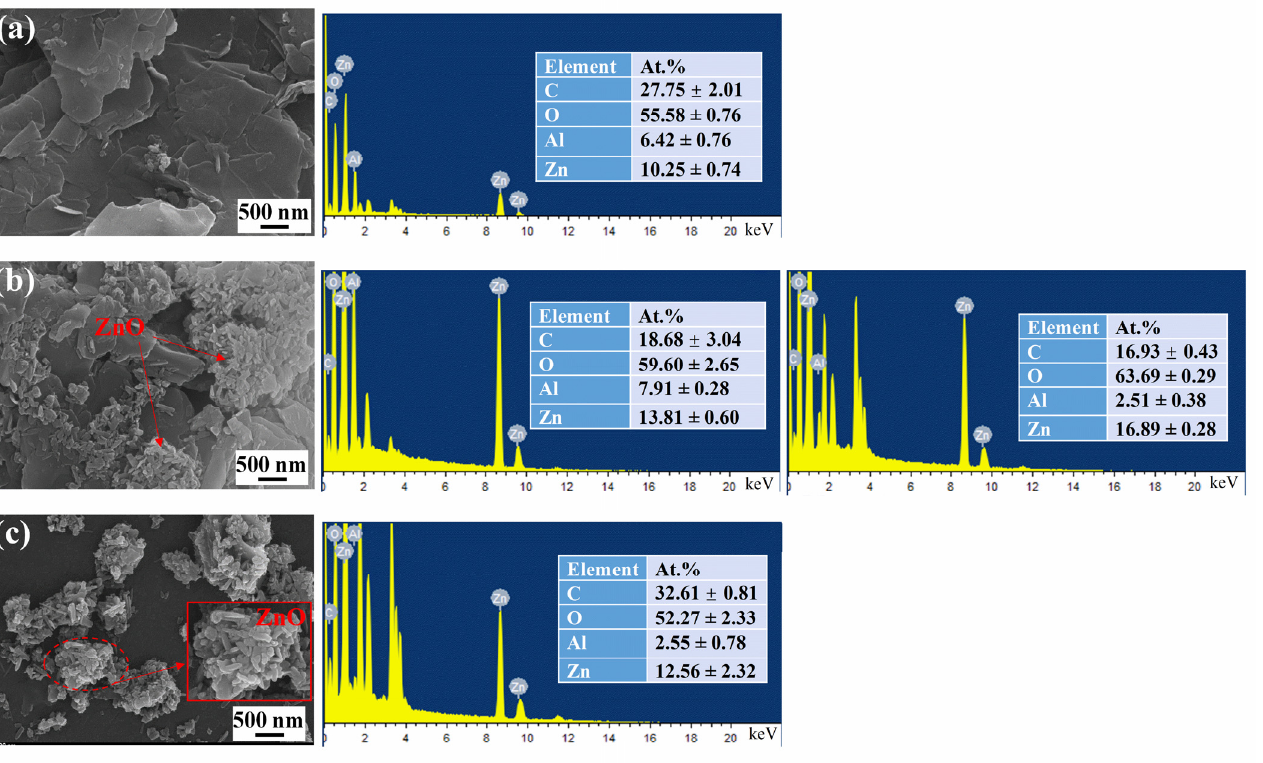
Figure 2. The SEM and corresponding EDS results of ( a ) Zn2Al1-LDH, ( b ) Zn3Al1-LDH, ( c ) Zn4Al1-LDH.